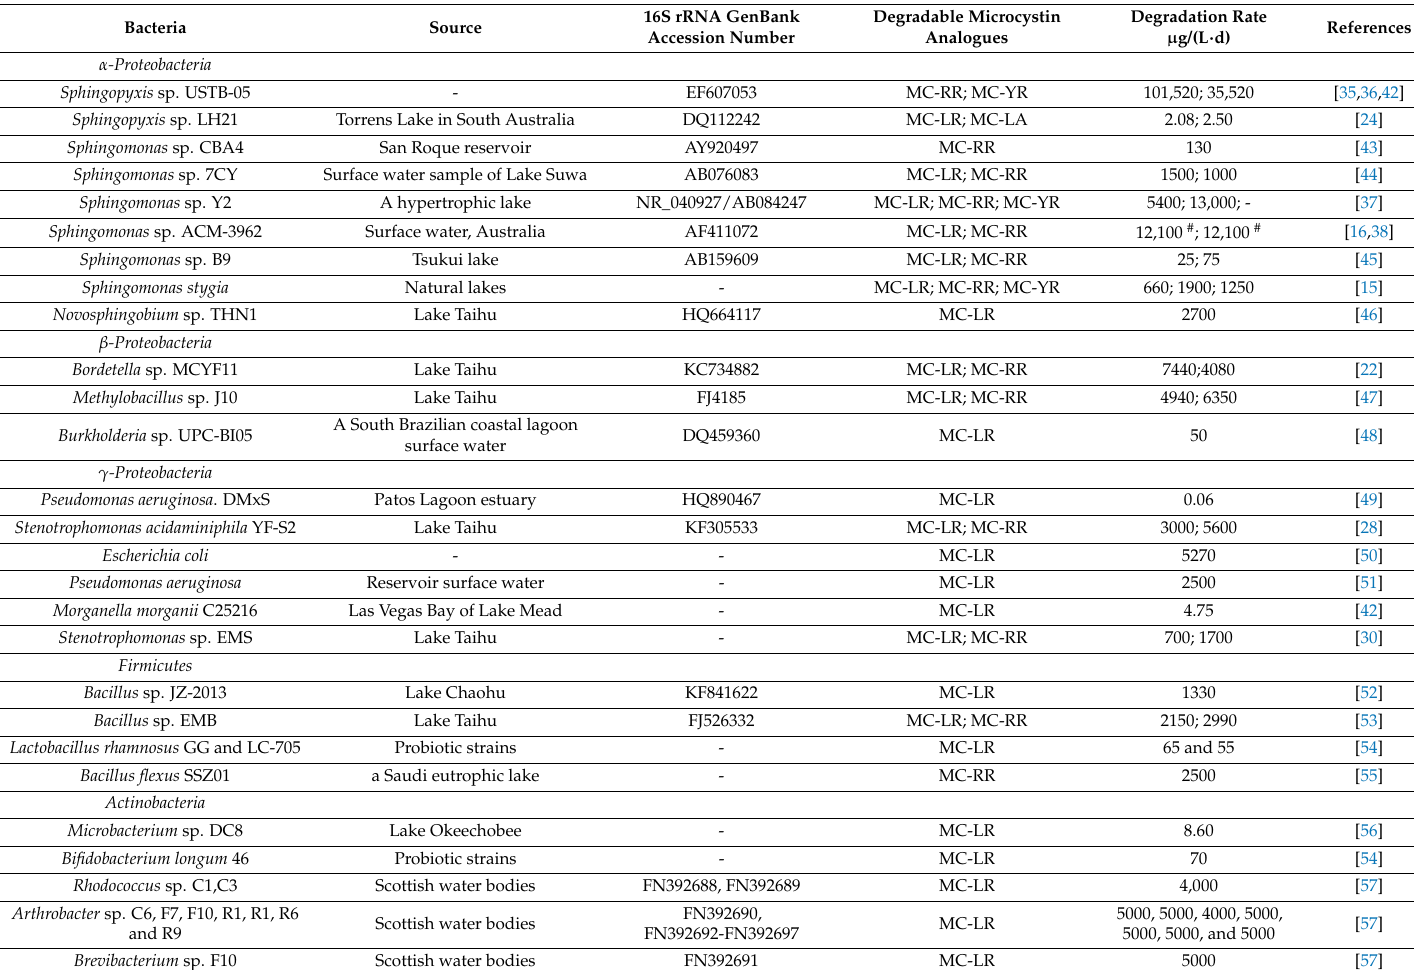
Table 2. Microcystin-degrading bacteria isolated in different areas and degradation